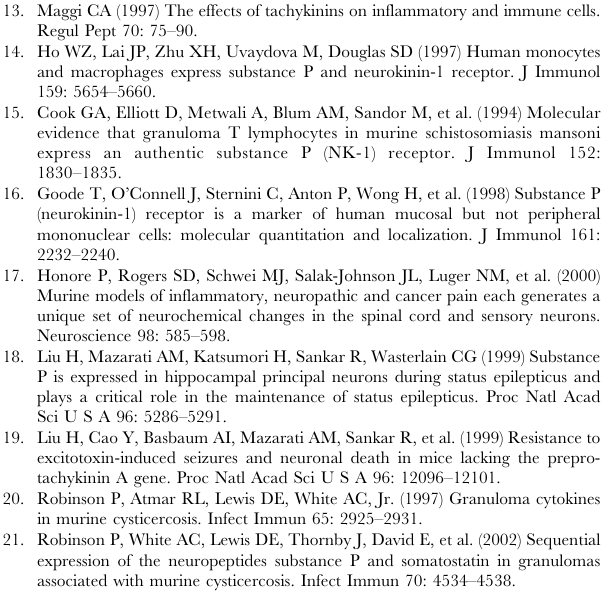
Figure 5. Effect of deletion of the NK1R gene or the SP gene in mice on granuloma extract-induced seizure activity. A representative EEG tracing after injection of an early granuloma extract obtained from a wild type mouse into the hippocampus of a wild type mouse (A) or NK1 2 / 2 (B) mouse is shown. The behavioral seizure grade (C), seizure amplitude (D), and seizure duration (E) in wild type or NK1 2 / 2 mice following intrahippocampal injection of extracts of early granulomas obtained from wild type mice (n=4 each) are depicted graphically (*, p # 0.001, Mann- Whitney). EEG recordings shown (F and G) are representative of results obtained after intrahippocampal injection into a wild type mouse of an extract from an early granuloma (F) or late granuloma (G) obtained from an SPP 2 / 2 mouse. Results are pooled data from two independent